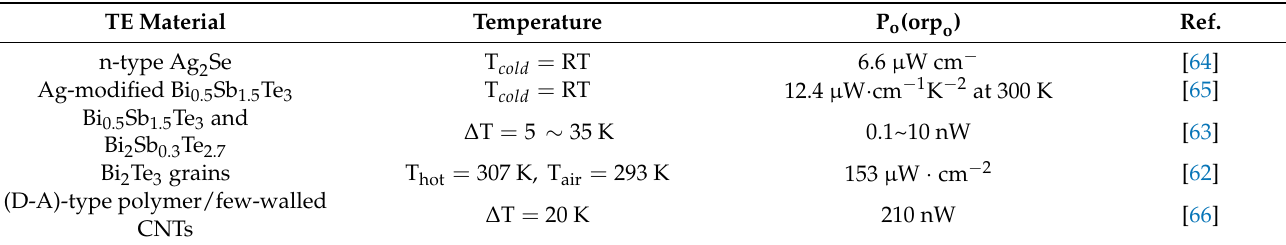
Table 5. Comparison of different flexible